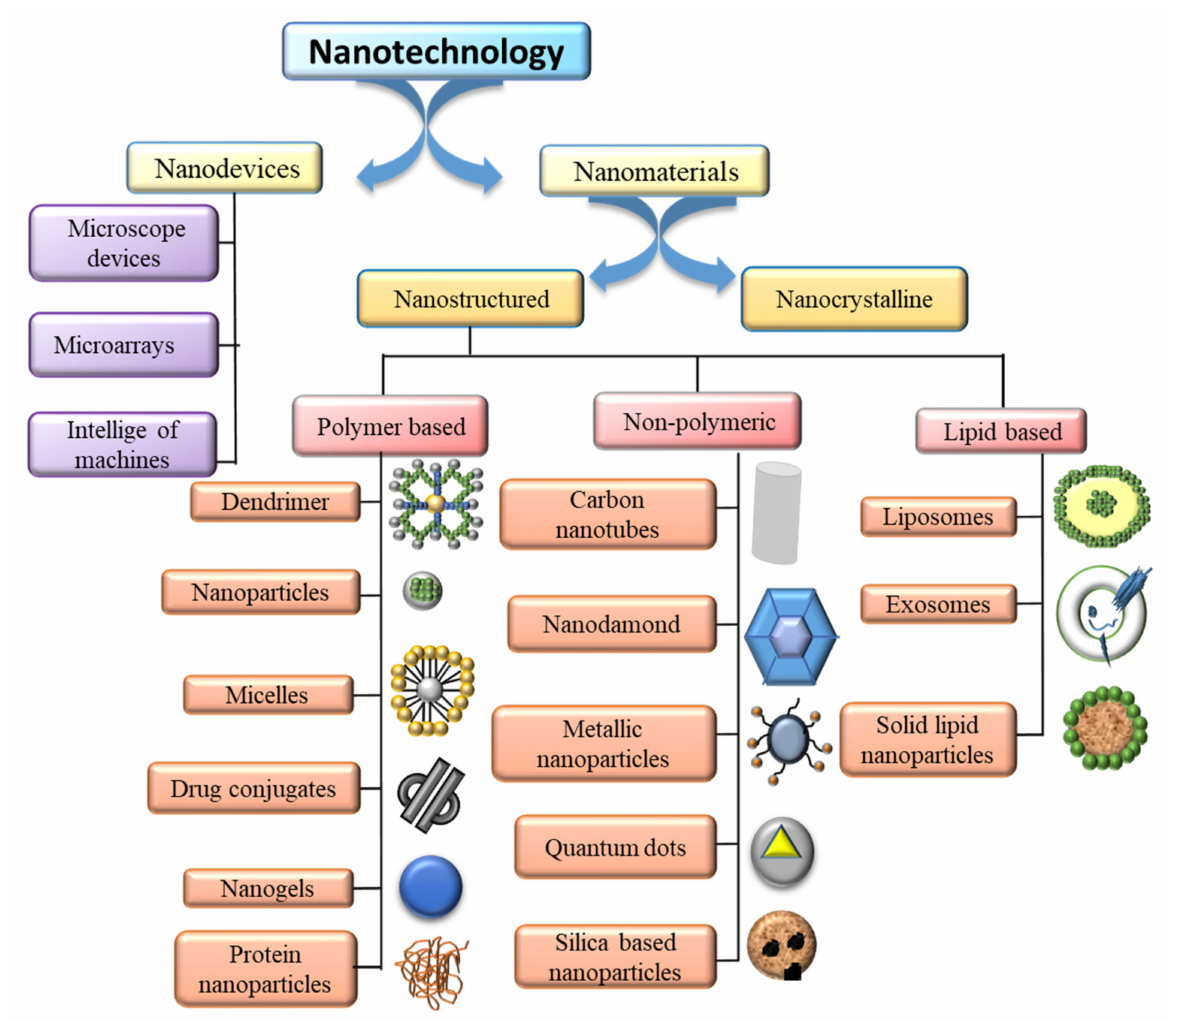
Figure 1. Classification of various kinds nanomaterials used for therapeutic